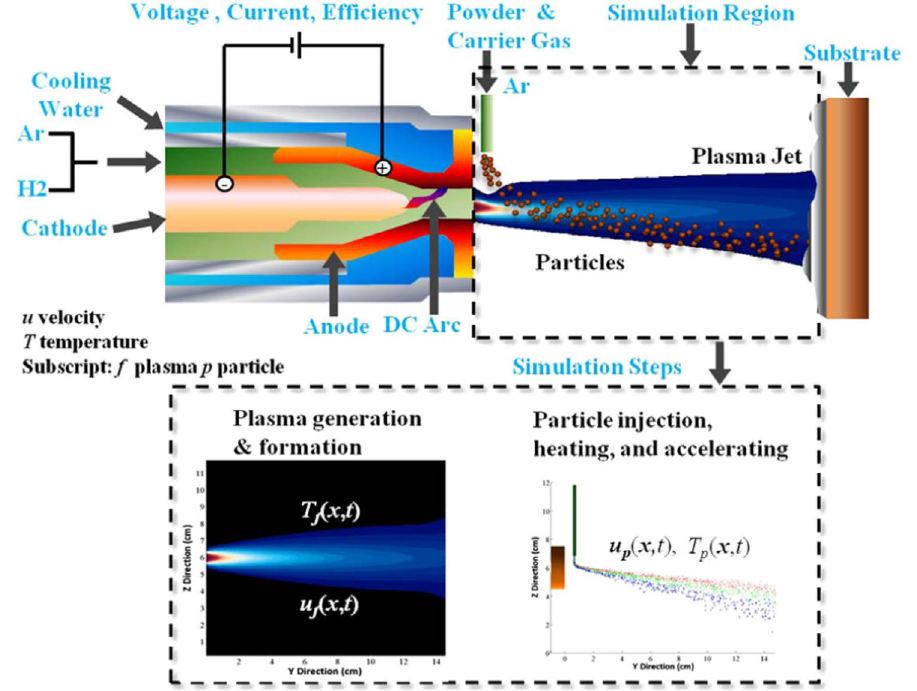
Figure 1. Schematics of an APSP, reproduced with permission from Shang et al. 2 . Gases injected into the gas